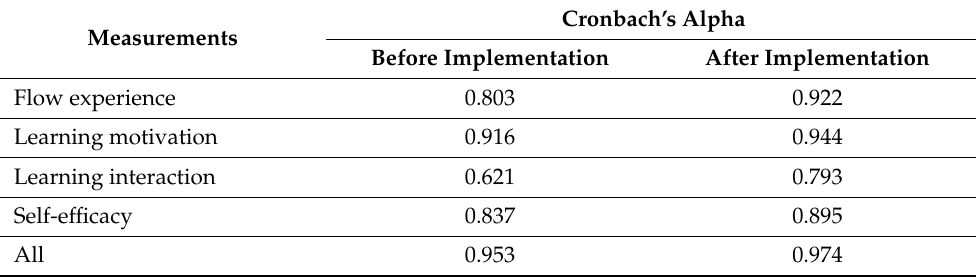
Table 5. Internal consistency analysis with quantitative data.